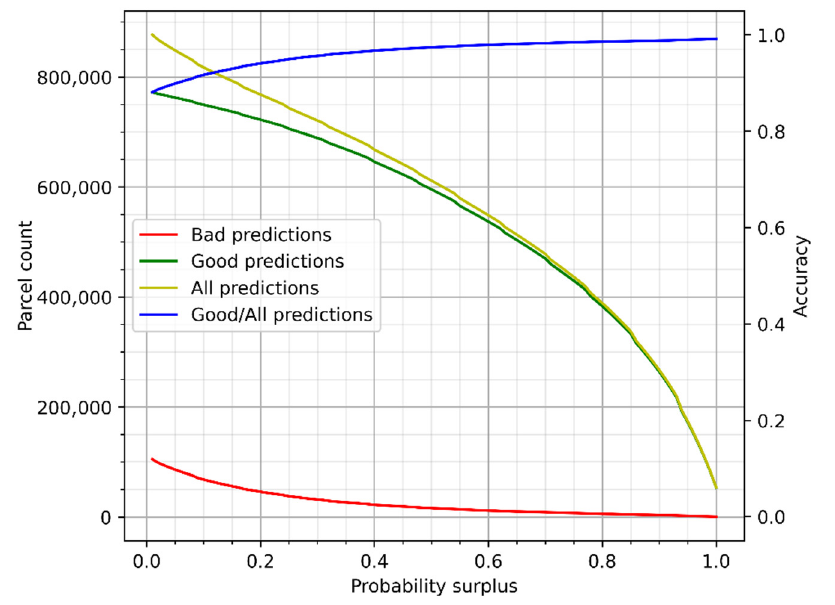
Figure 6. Cumulative histogram of parcels identified as correct and incorrect, ordered by probability surplus. This graph supports decision on certainty levels for notifying non-compliant cases.